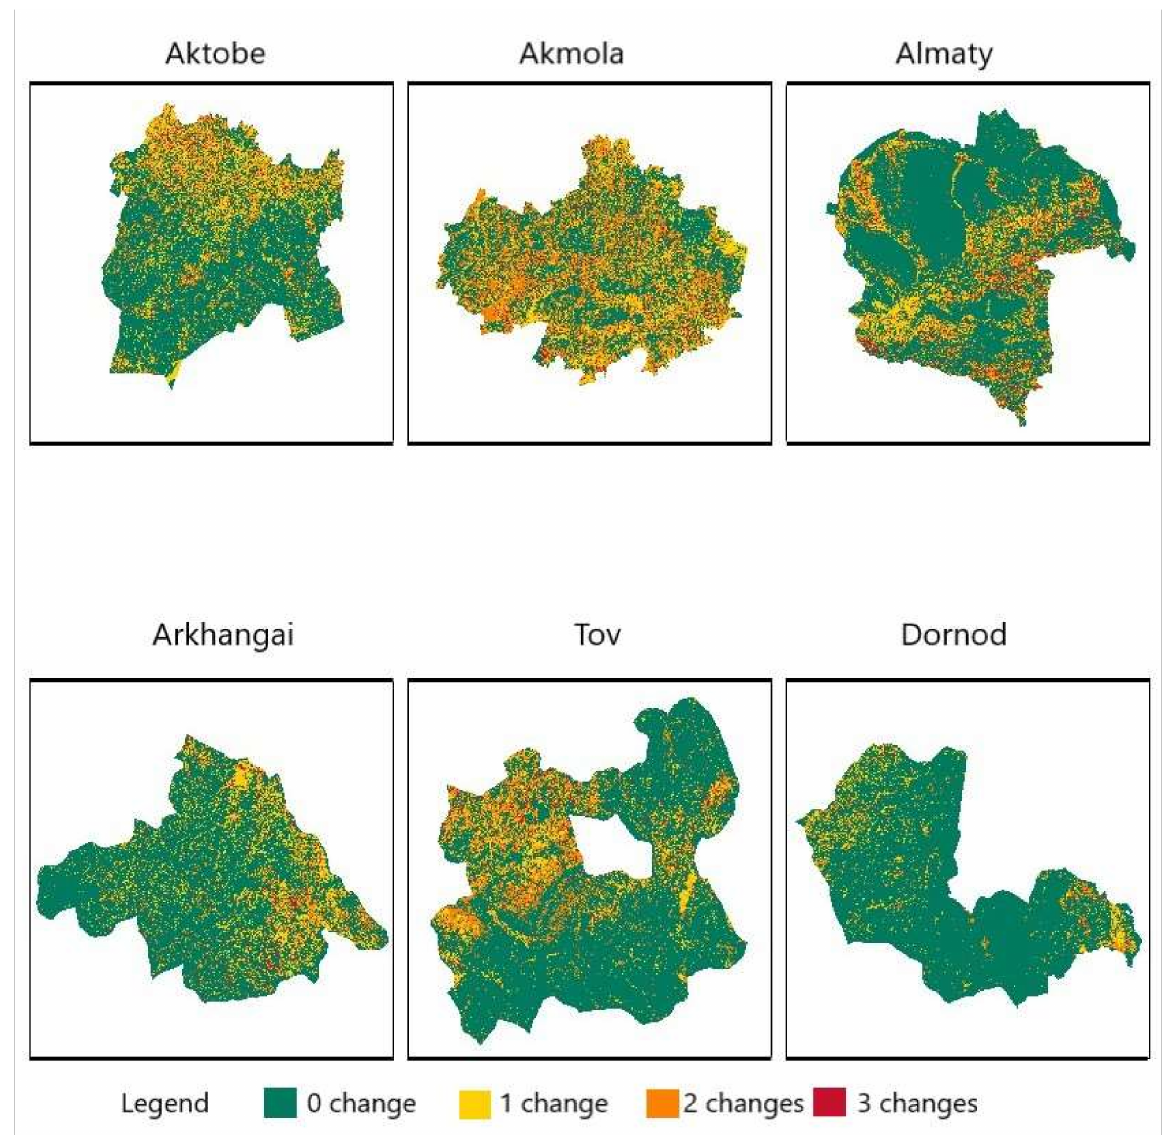
Figure 8. Hotspots of land cover change identified with iLCC which was computed the number of times a pixel that changed during the study period within a province. A pixel can change from one to three times during three time periods (i.e., 1990–2000, 2000–2010 and